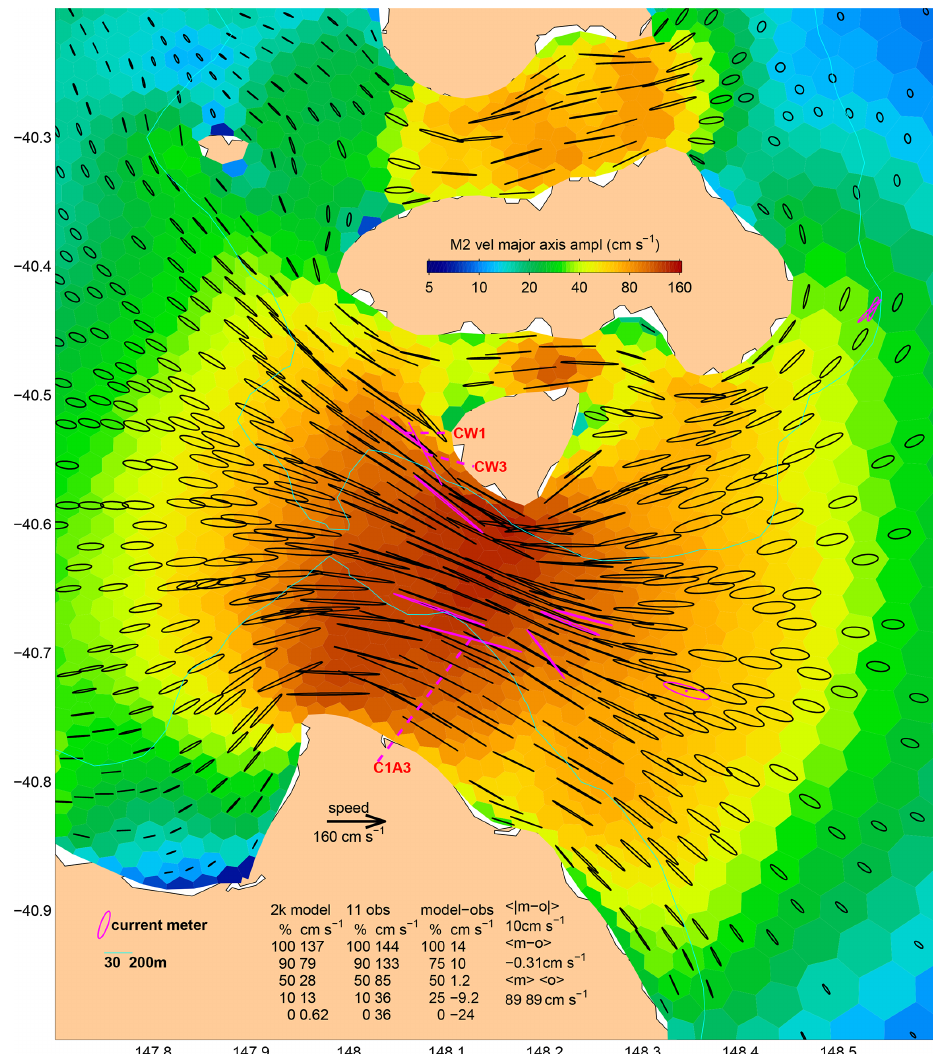
Figure 7. Amplitude of the M2 major axis velocity for Banks Strait; otherwise like Fig.